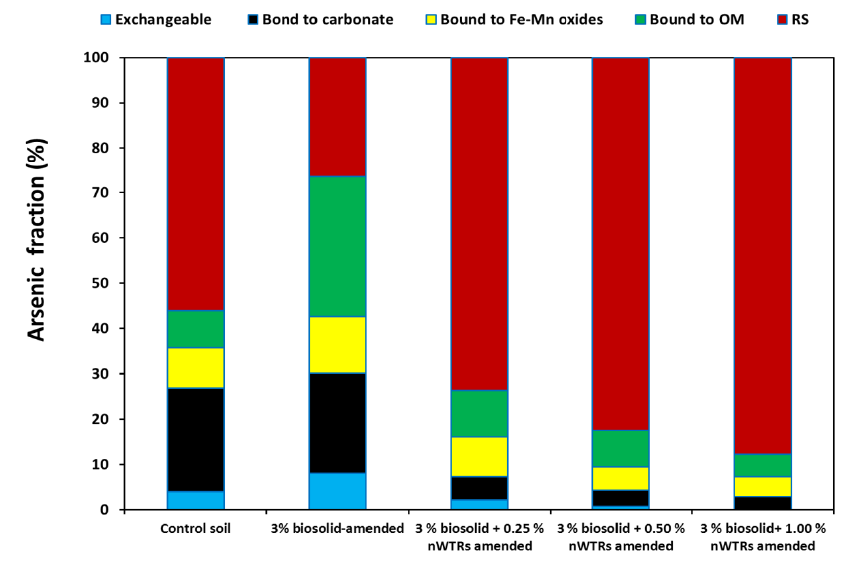
Figure 3. Percentage of arsenic (As) fractions in the calcareous soil amended with biosolids (3%, w/w) and treated with different levels of nWTRs of 0%, 0.25%, 0.50%, and 1% (w/w). OM: organic matter; RS: residual fraction.